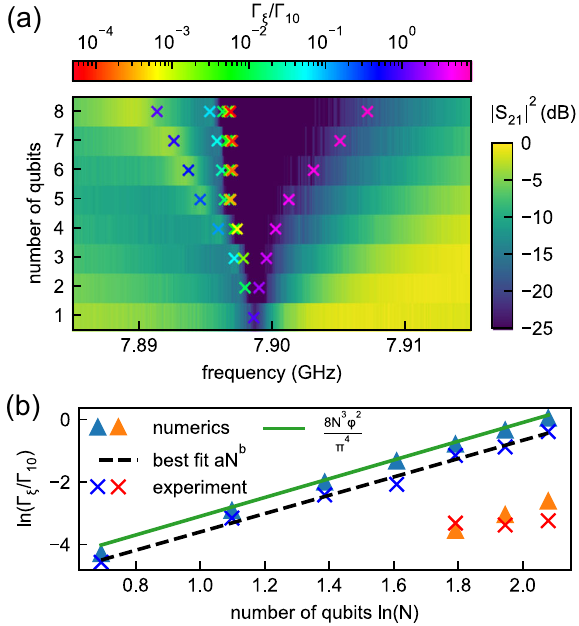
Fig. 1 Sample and transmission. a Optical micrograph of the metamaterial. It is composed of eight superconducting transmon qubits capacitively coupled to a coplanar waveguide. Local fl ux-bias lines provide individual qubit frequency control in the range 3 – 8 GHz. b Transmission ∣ S 21 ∣ for different numbers N of resonant qubits at ω r /2 π = 7.898 GHz and low drive powers. With increasing N , the emergence of subradiant states (visible as peaks in transmission) can be observed. Black dotted lines are fi ts to the expected transmission using a transfer matrix calculation. Black arrows mark calculated frequencies of the two brightest subradiant states for N = 8.